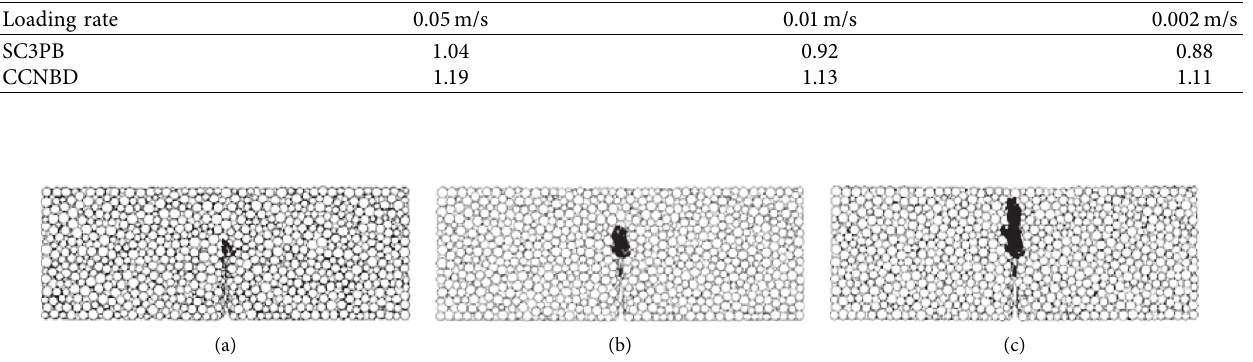
Table 4: Test results of fracture toughness under different loading rates.